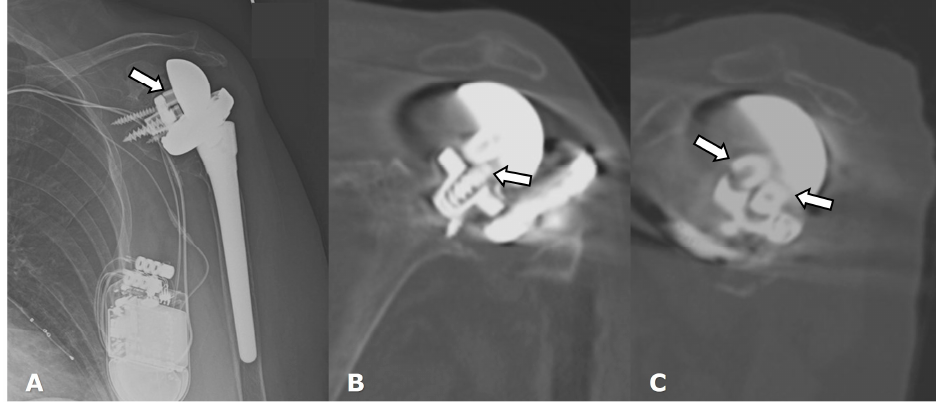
Figure 27. ( A ) Frontal radiograph and ( B ) coronal and ( C ) parasagi tt al CT images in a patient with RTSA show dissociation of the glenosphere from the metaglene/baseplate central screw (arrows).